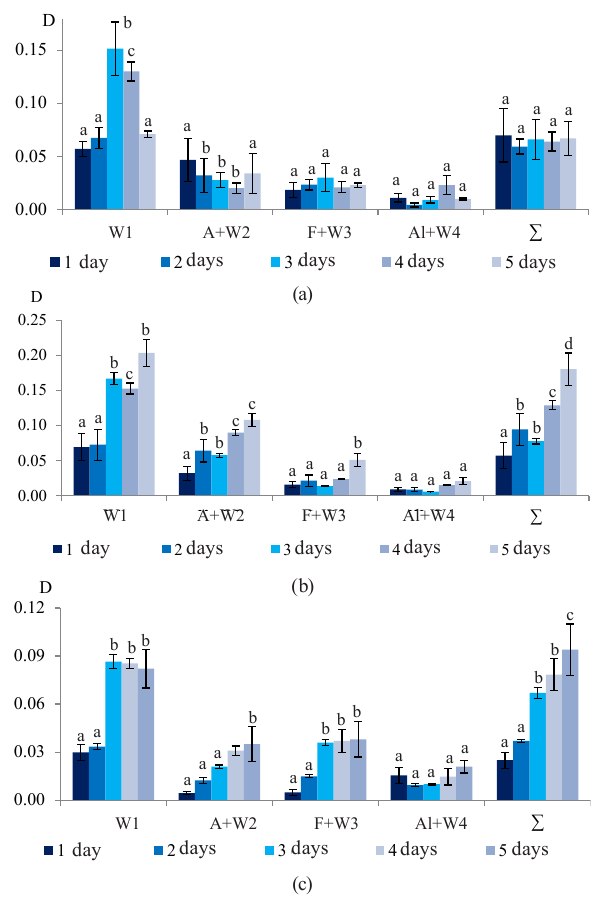
Figure 5 Dependence of the optical density (D) of washings of biofilms formed on glass in permeates of skimmed milk (a), sweet whey (b), and acid whey (c) on processing conditions (W1 – water, A + W2 – acid solution and water; F + W3 – enzyme solution and water; Al + W4 – alkali solution and water; Σ – sum of D for A + W2, F + W3 and AL + W4 washes). Letters a, b, c, d show significant differences ( P ≤ 0.05) between the mean values in the same series of D values for one type of